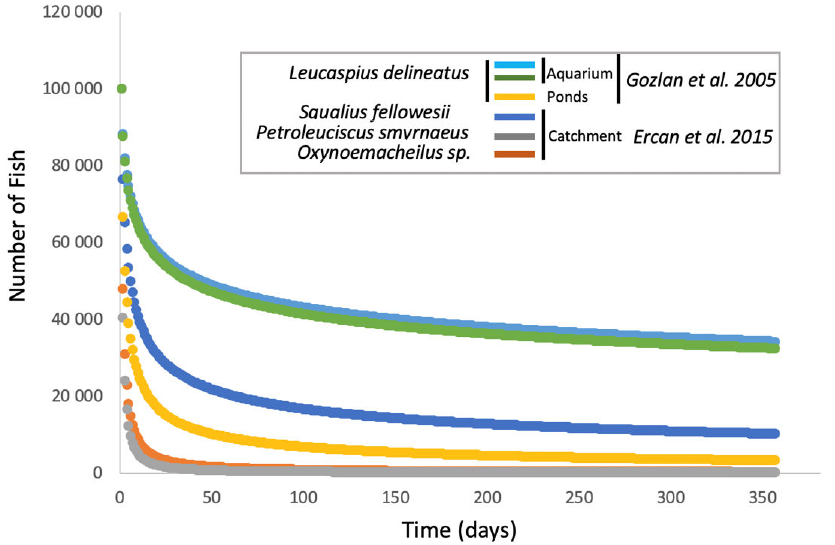
Figure 2. Mortality curves after infection with the rosette agent Sphareothecum destruens in different species and under different environmental conditions (based [27,32] for data and [39] for